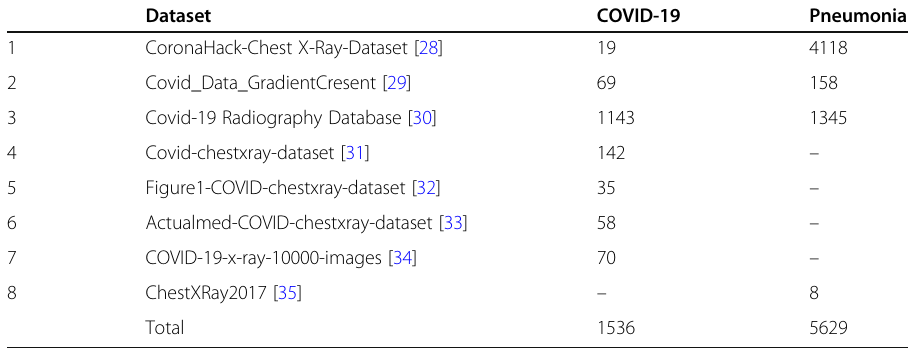
Table 1 List of databases used in this